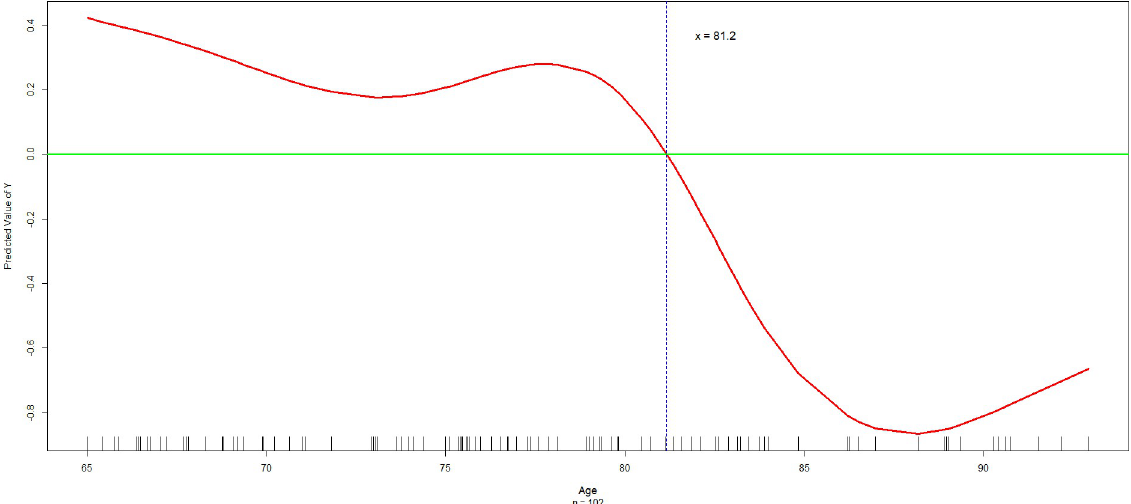
Fig 1. The plot of the fitted multiple generalized additive model (GAM) for estimating the partial effect of “Age” (years) on the “change score of the Lawton IADL scale”, adjusted for the effects of the “Problem solving score of the CDR” and the smoothed “MMSE score”. The change score of the Lawton IADL scale = The current score of the Lawton IADL scale − The Lawton IADL scale at baseline. Lawton IADL scale = Lawton Instrument Activities of Daily Living scale; CDR = Clinical Dementia Rating scale; and MMSE = Mini-Mental State Examination. The cut-off value of 81.2 years for “Age” was estimated by the intersection of the smoothed red curve and the green straight line at Predicted value of Y = 0. The many little vertical bars (called the rugs ) right above the X -axis indicated where the observed values of “Age” located. The technical details of the GAM plot were described in the Materials and methods